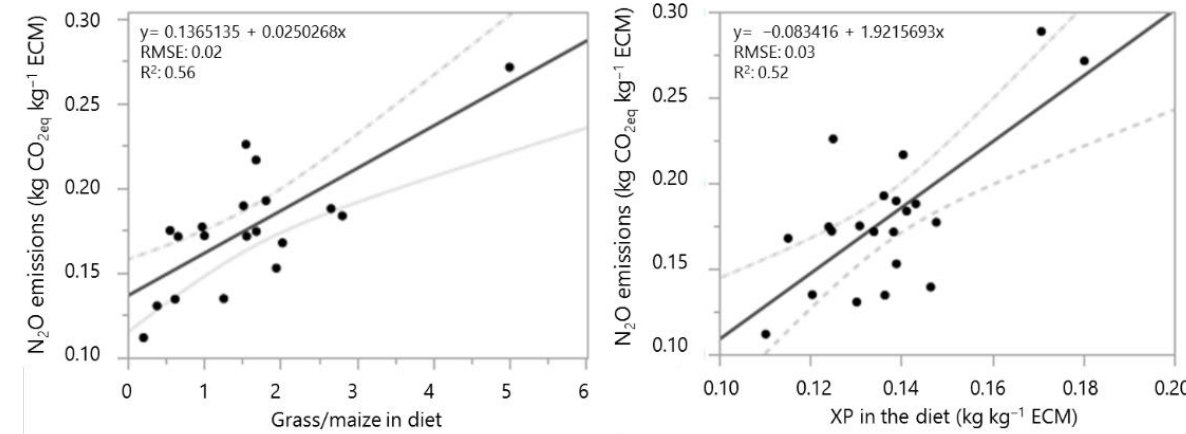
Figure 6. Effects of the grass/maize ratio and of the diet protein content (XP) on N 2 O emissions from the analysed dairy farms, expressed as t CO 2eq ha −1 per year.